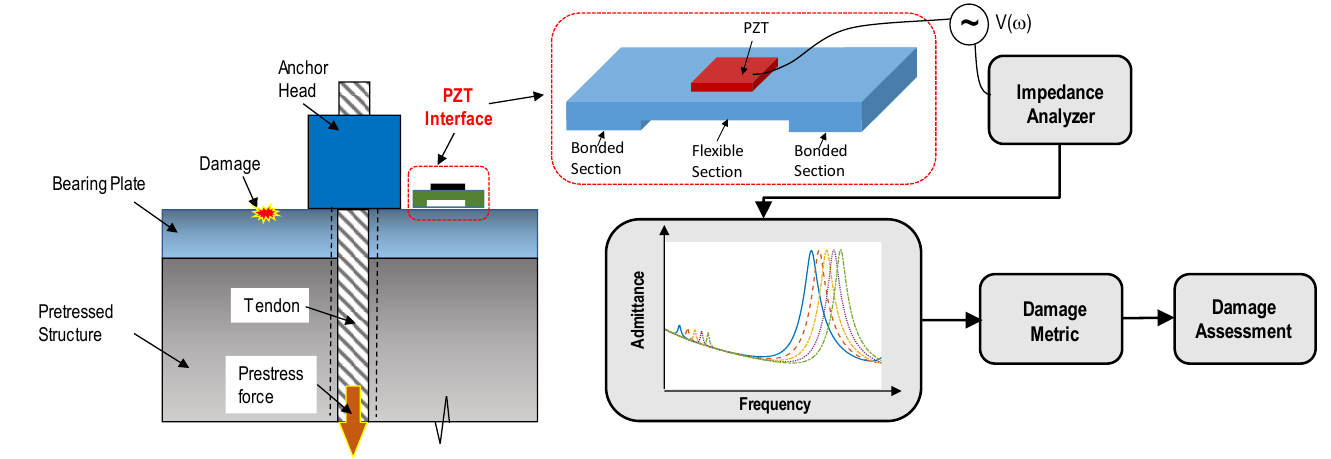
Figure 1. The admittance-based active sensing technique for damage monitoring of prestressed an- chorage.